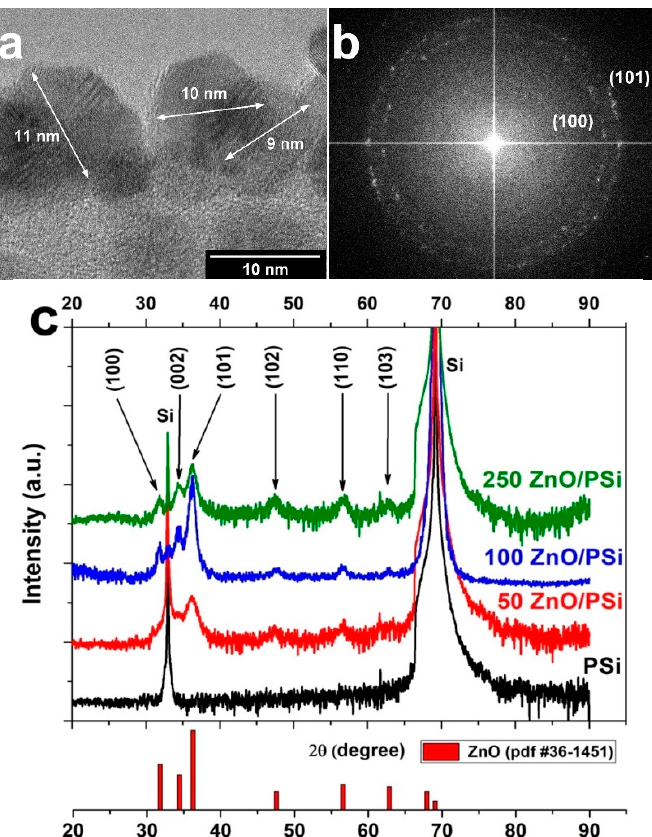
Figure 2. ( a ) TEM imaging of ZnO nanocrystallites on PSi obtained after 100 ALD cycles; ( b ) FFT of the PSi / ZnO TEM image; ( c ) GIXRD spectra of PSi / ZnO nanocomposites with 250, 100, and 50 ALD cycles of ZnO in comparison to GIXRD spectrum of PSi. Standard diffraction peaks of wurtzite (pdf card #36-1451) are presented for reference.